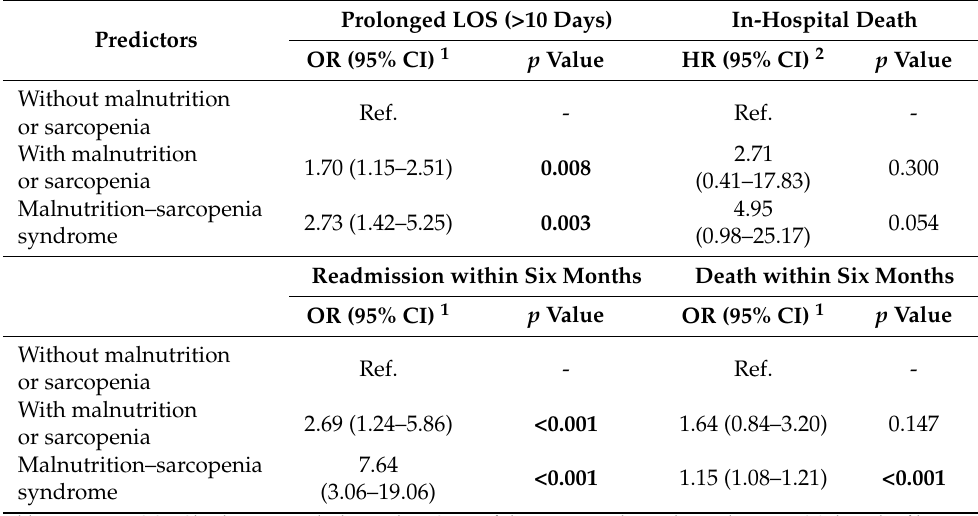
Table 3. Association of sarcopenia or/and malnutrition with clinical outcomes: multivariate